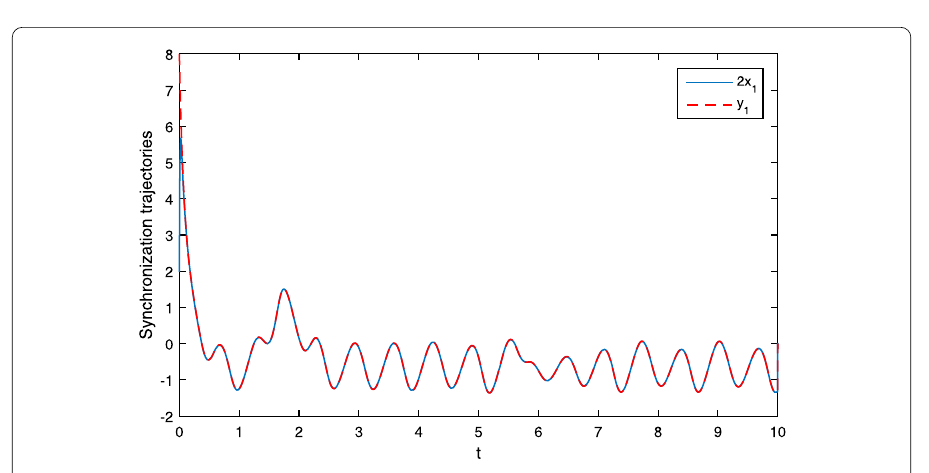
Figure 3 The synchronization trajectories of x 1 , y 1 with β = 2